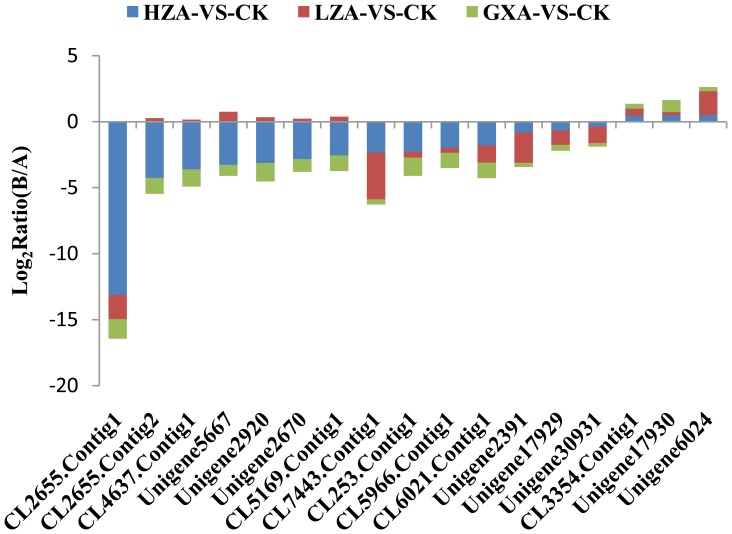
The expression trend and level of ryanodine receptor genes for the gradient differentially expressed genes.